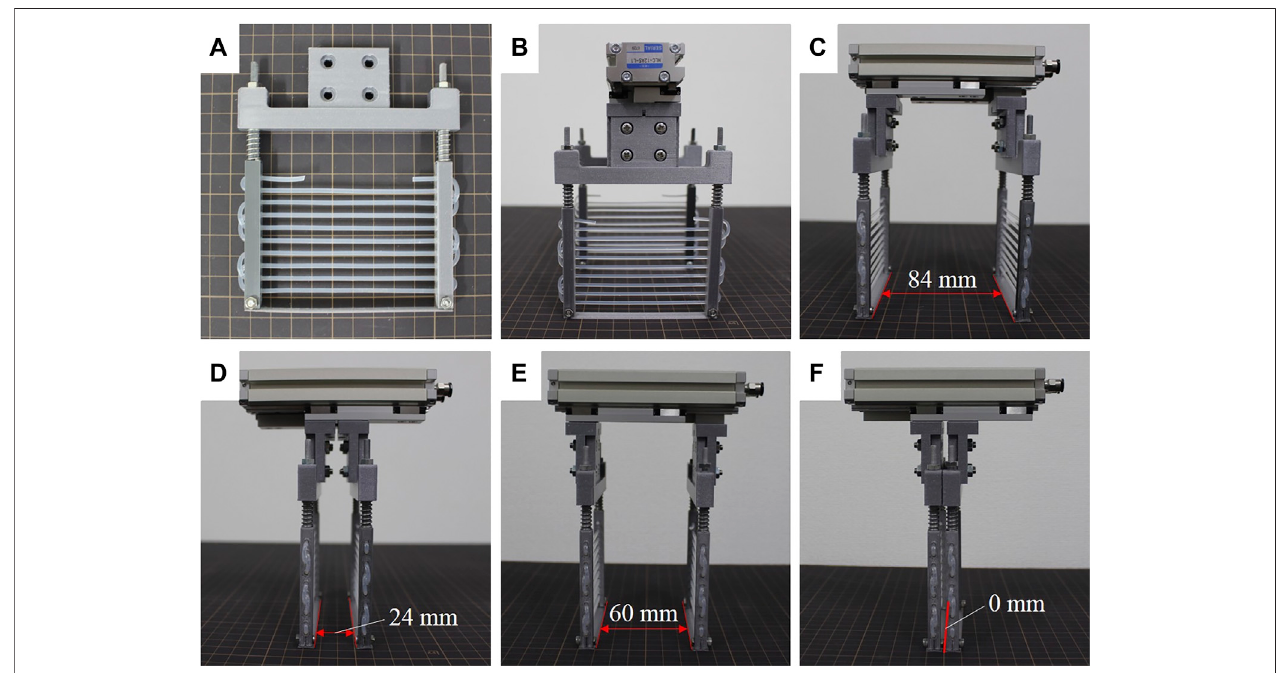
FIGURE2| Fabricatedscooping-bindinggripper. (A) showsthescooping-bindingmechanism, (B) depictstheassembledgripper, (C) and (D) showtheopenand close states in wide con fi guration, and (E) and (F) show the open and close states in narrow con fi guration.